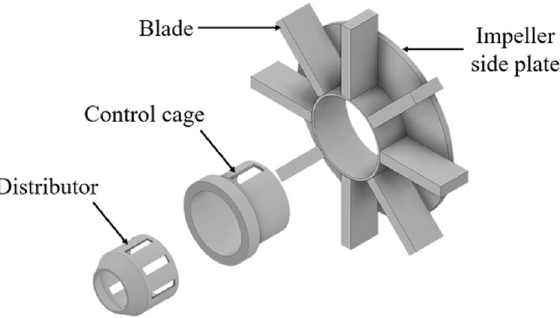
Figure 1. Schematics of impeller-type shot blaster (Inventor 2021, https:// www. autod esk. com/ produ cts/ inven tor).